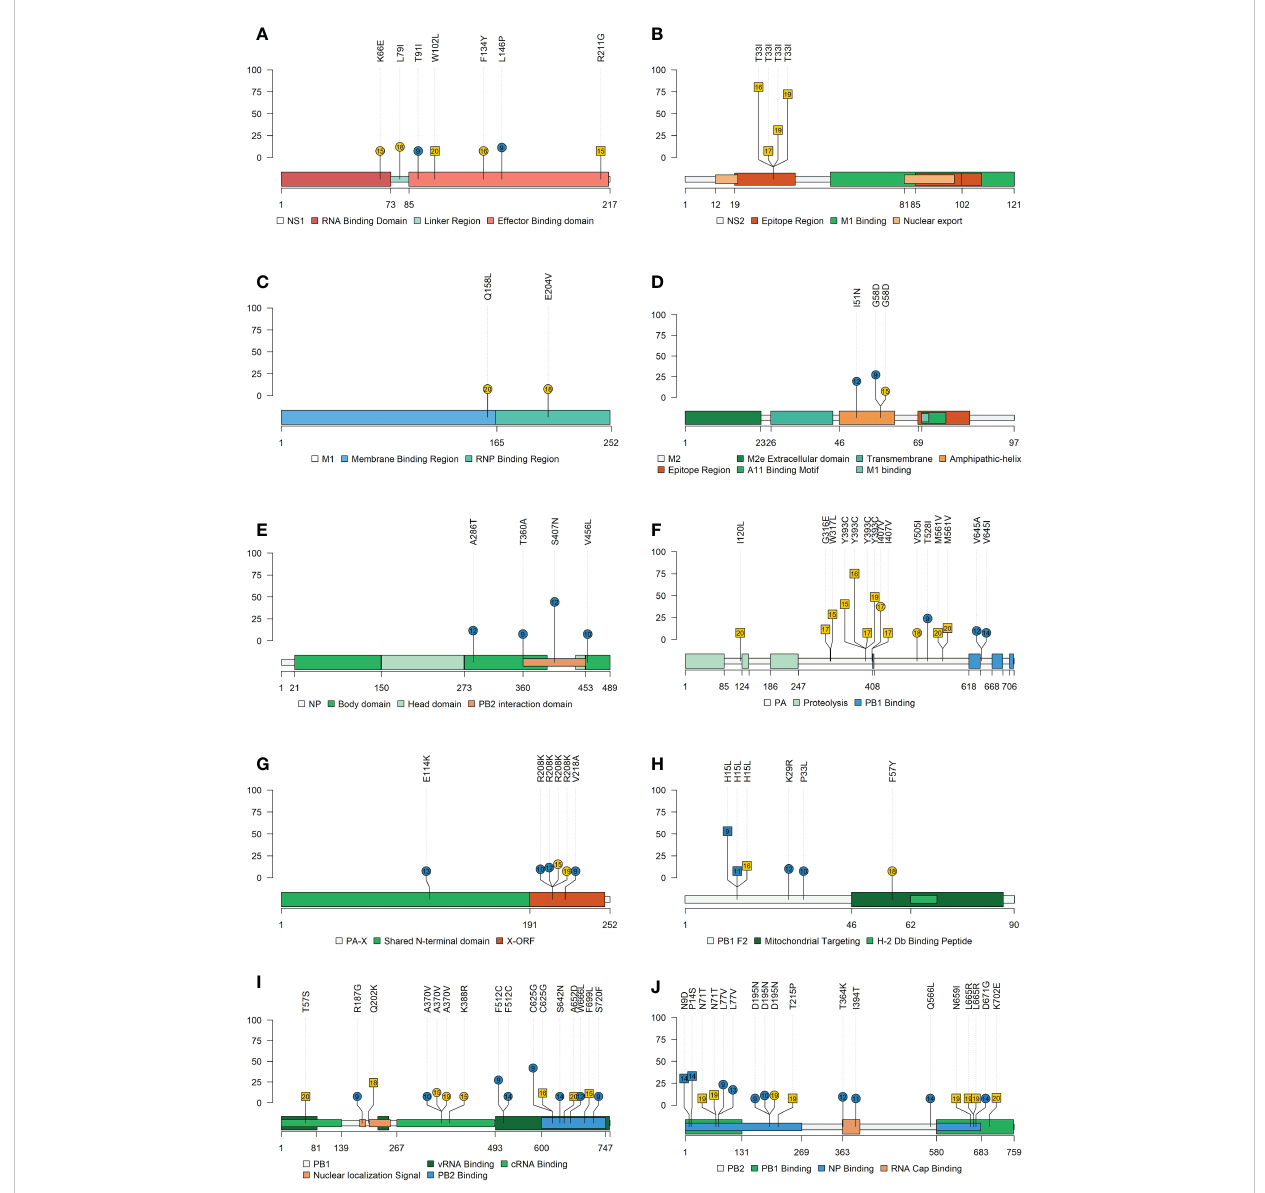
FIGURE 9 Lolliplot representation of nonsynonymous SNV allocation on swine IAV proteins. Substitutions found in NS1 (A) , NS2 (B) , M1 (C) , M2 (D) , NP (E) , PA (F) , PA-X (G) , PB2-F2 (H) , PB1 (I) and PB2 (J) proteins with an allele frequency greater than 5%. In the ordinate axis, the allele frequency of each substitution is indicated. Substitutions noted in blue and yellow show substitutions found in vaccinated and nonvaccinated animals. Besides, the circle shape indicates that substitution was reported in H1N1 subtype, whereas substitutions found in H3N2 are represented by square shapes. The number inside each shape indicates the pig ID of each reported substitution. Figure legends indicate the most important domains of each